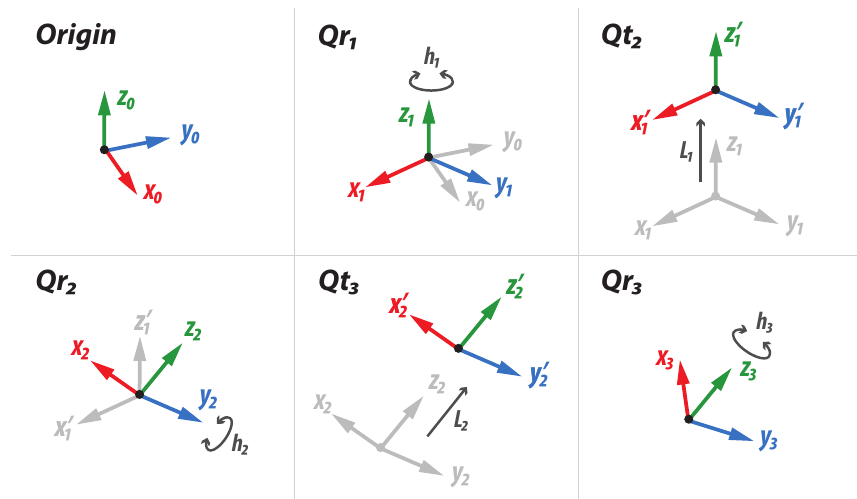
Figure 7. Development of transformations for the rational orientation